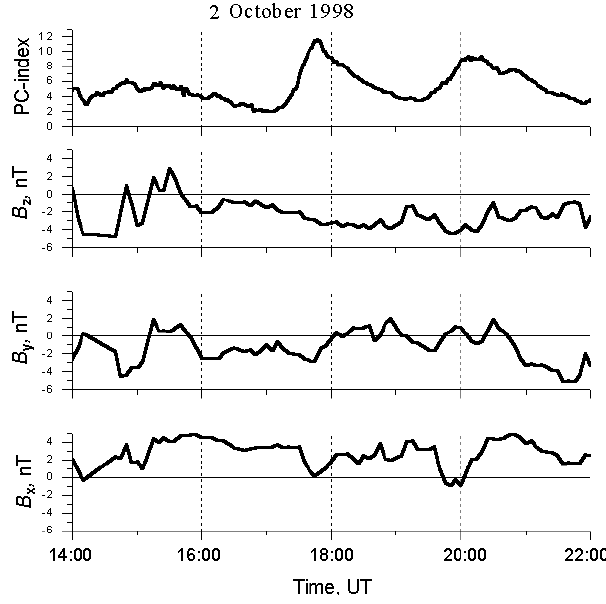
Fig. 1. The temporal behavior of the PC index of the magnetic Figure 1. The temporal behavior of the PC index of the magnetic activity, B z , B y , and B x activity, B z , B y , and B x components of the interplanetary magnetic components of the interplanetary magnetic field on 2 October 1998. field on 2 October 1998.